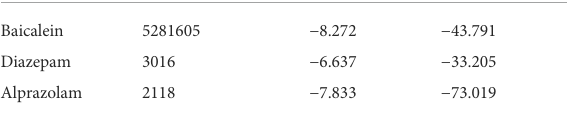
TABLE 2 Docking analysis of ligands against GABA(A) Receptor (PDB ID: 6X3X).